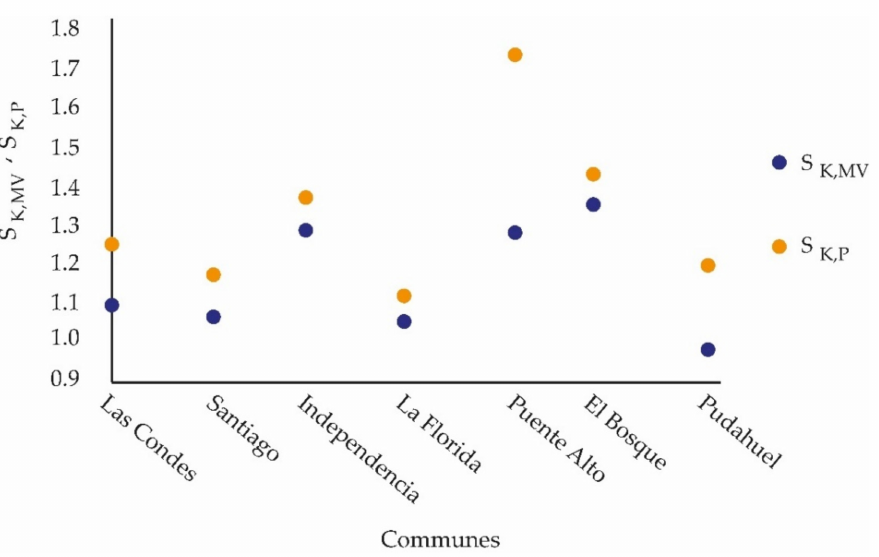
Figure 6. Entropy for the quotient between accumulated sick people/localized climatology and accumulated sick people/pollutants, for each